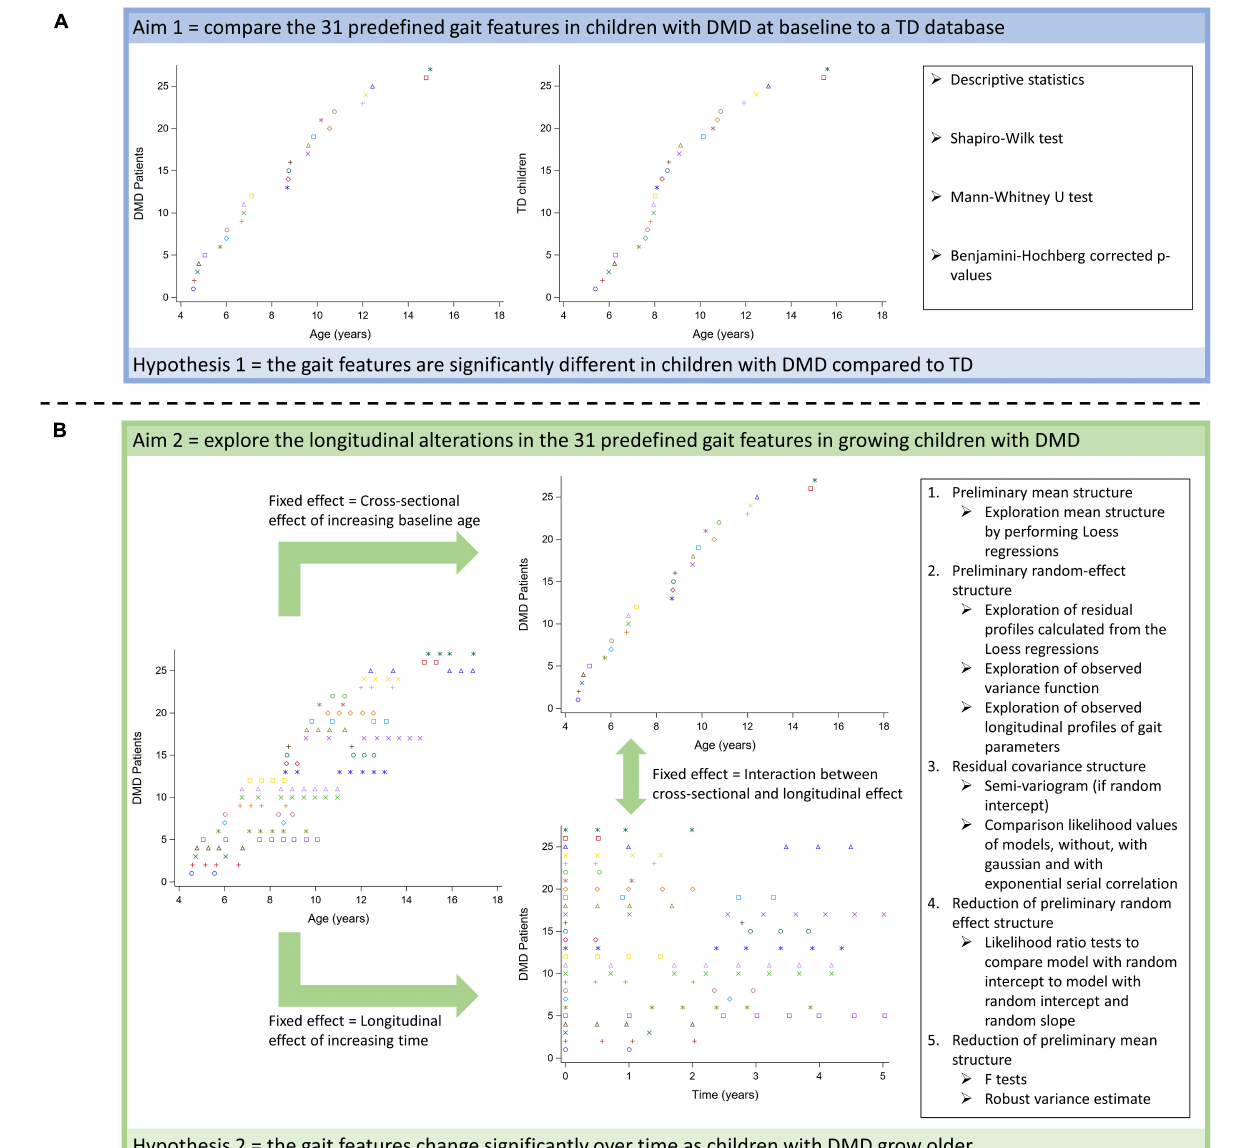
FIGURE 2 | Schematic overview of statistical analyses to achieve the first (A) and the second aim (B) .